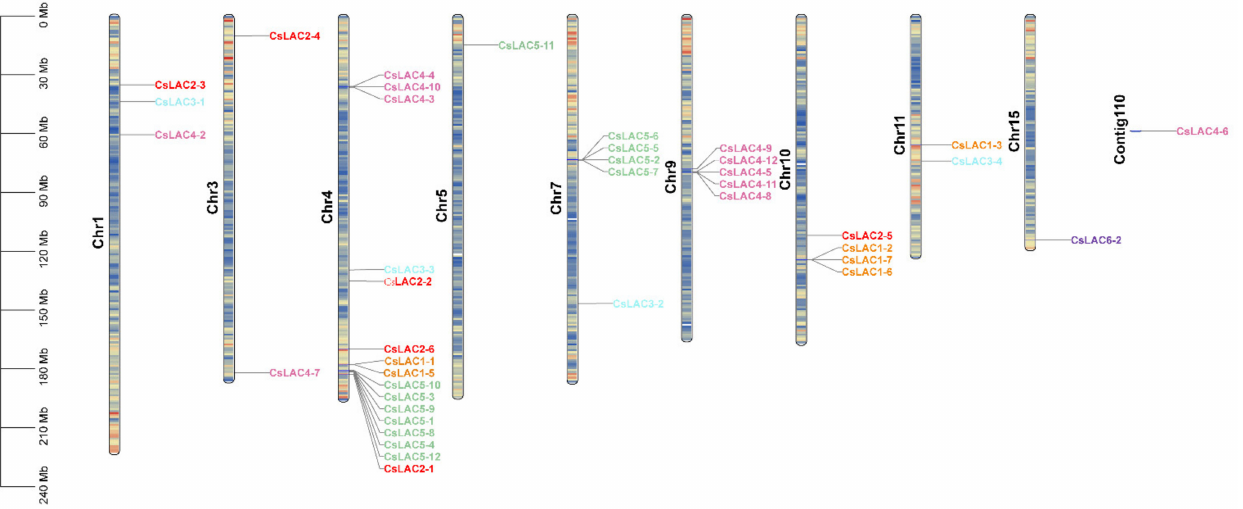
Figure 2. Chromosomal localization and clustering of CsLAC s in tea genome. Some chromosomes e.g., 4, 7 and 9 contain higher number of CsLAC s, but 5 and15 chromosomes each possesses only one CsLAC , presenting uneven distribution throughout the